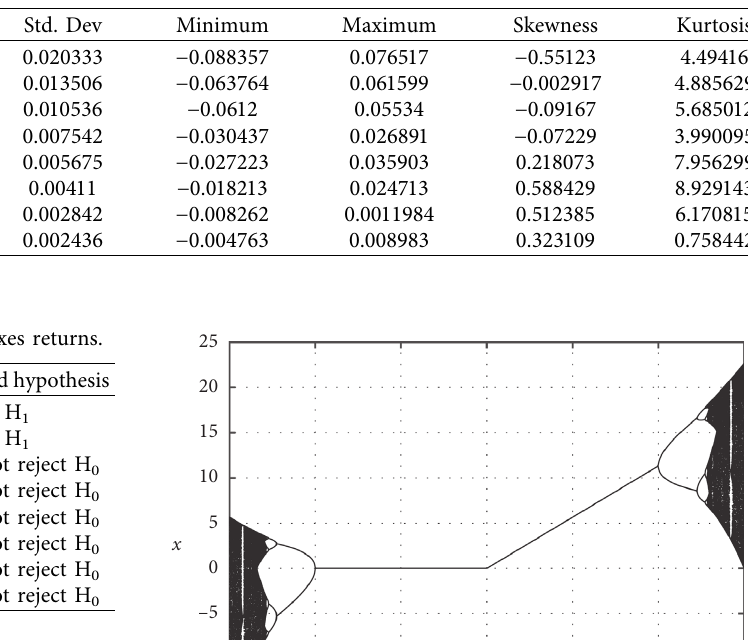
Table 1: Descriptive statistics of the agriculture index returns in different scales.